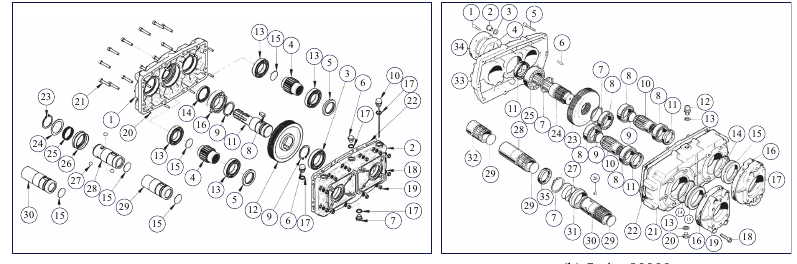
Figure 6. Explosion diagram of splitter